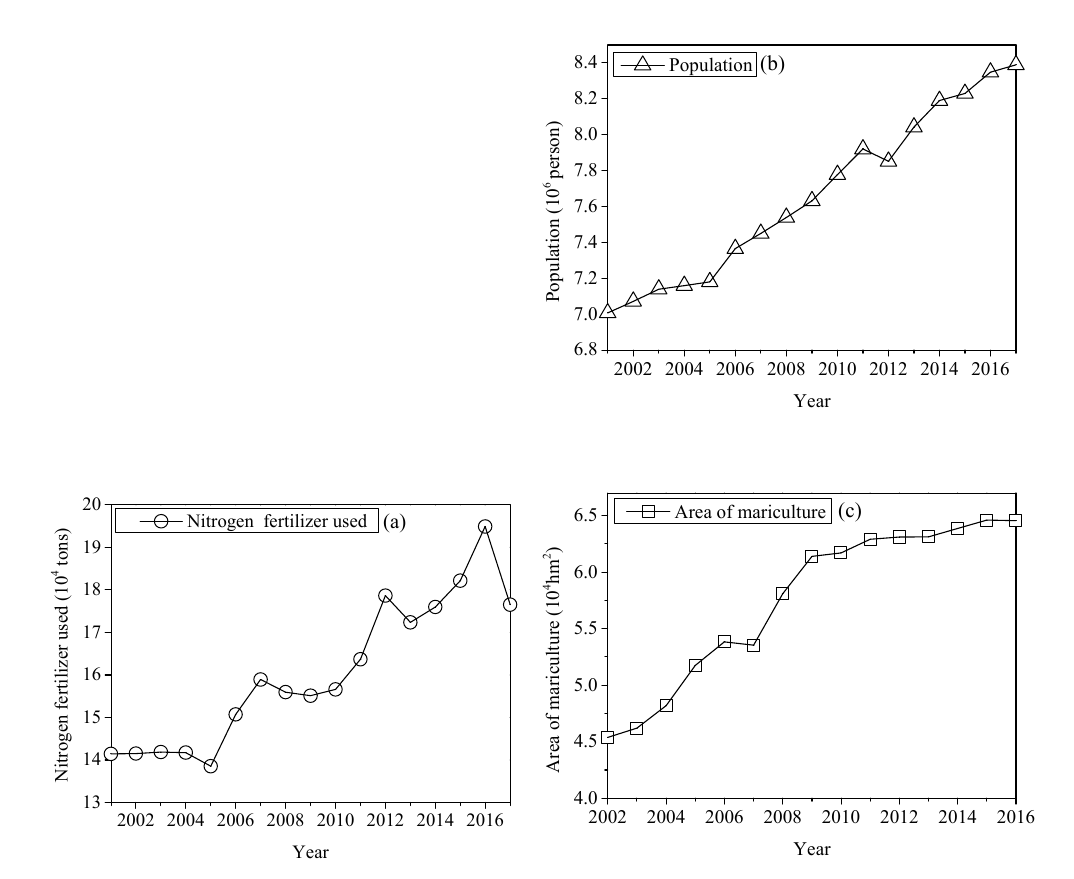
Figure 7. Annual change in nitrogen fertilizer used ( a ), population ( b ), and the areas of mariculture ( c ) in Zhanjiang [67].